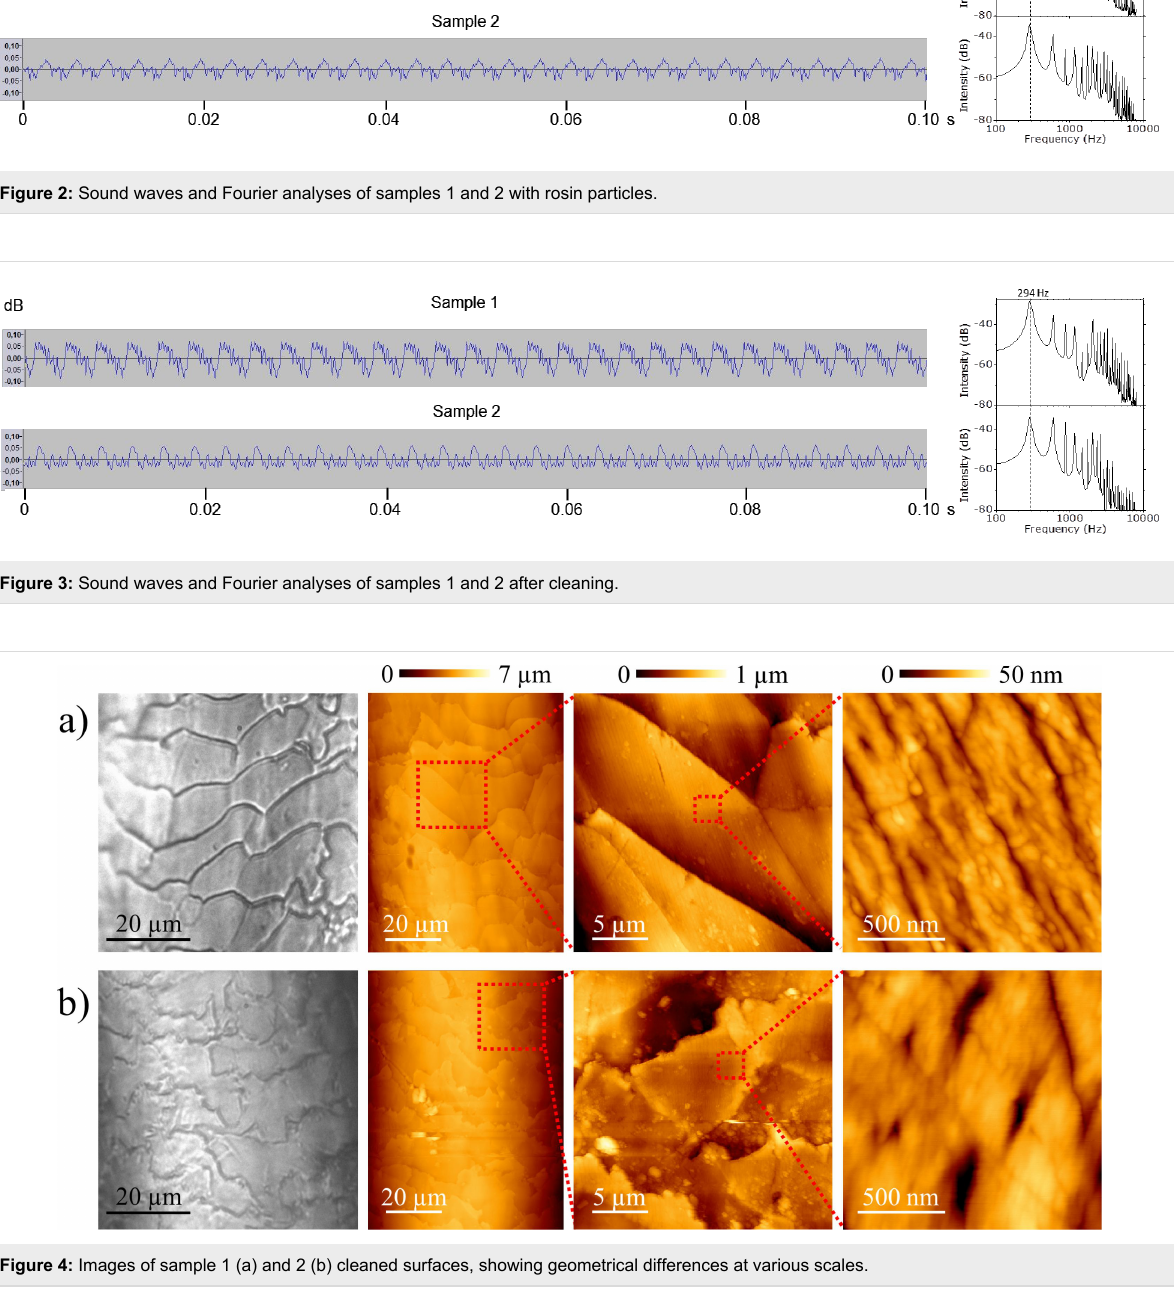
geometrical characterization of the D-string topography is also required. This is shown in Figure 5, where the same magnifica- tions as in Figure 4 were selected. Other violin strings were also inspected, but they all presented similar surface characteristics at these scales. Hence, only a representative D-string was analyzed in